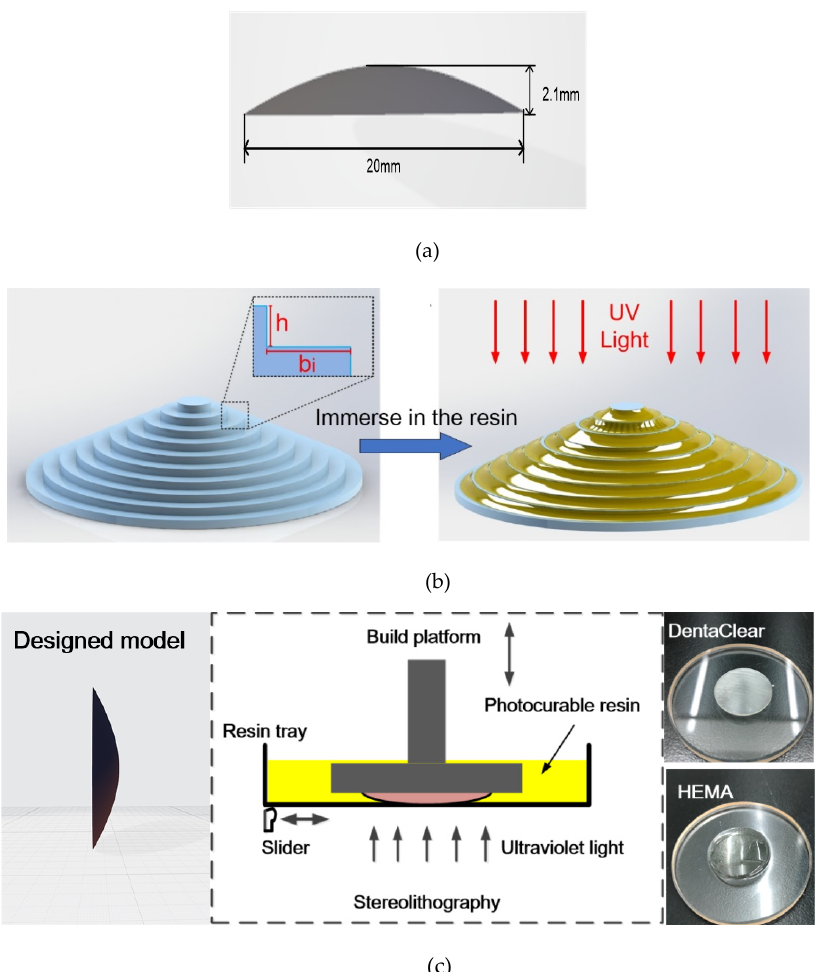
Figure 3. ( a ) STL model of the designed aspheric lens. ( b ) Sliced model of the designed lens and meniscus equilibrium post-curing process. ( c ) Two kinds of resins were structured in a stereolithography 3D printer respectively, and 3D-printed aspheric lenses on a fused silica